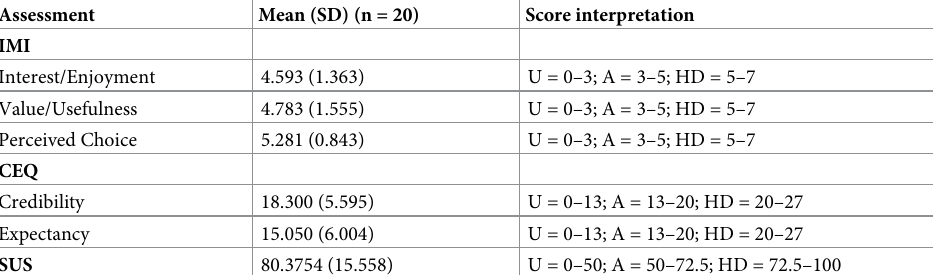
Table 2. Mean and standard deviation (SD) outcomes of Intrinsic Motivation Inventory (IMI), Credibility/Expec- tancy Questionnarie (CEQ) and System Usability Scale (SUS) of patients with neuromotor disorders. The interpre- tation of the mean scores for each subscale is provided in the form: U = unacceptable outcome; A = acceptable outcome; HD = highly desirable outcome.